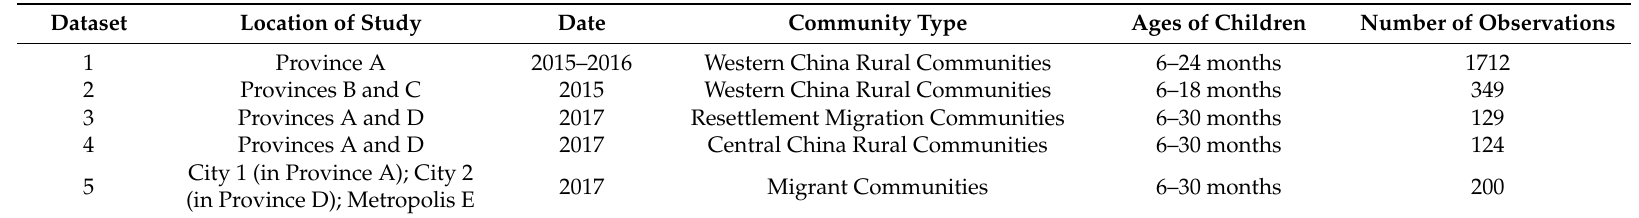
Table 1. Summary of the distribution and location of data sets